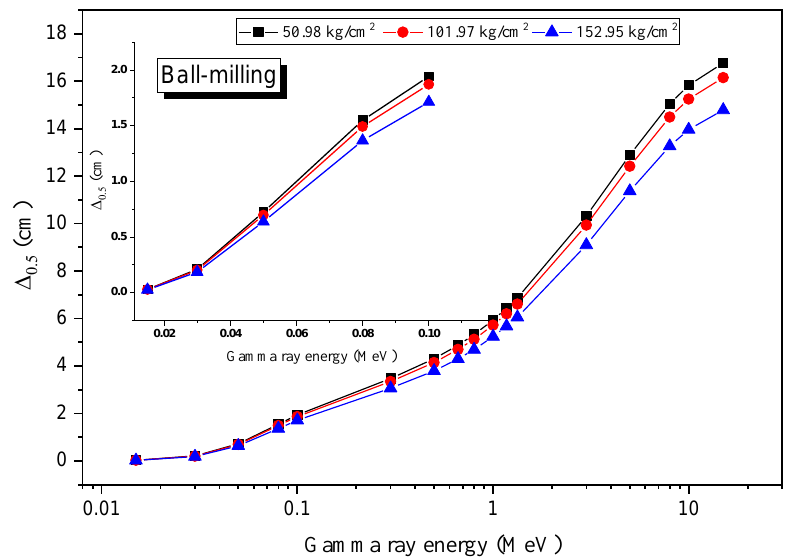
Figure 9. Variation in the half-value thickness versus the energy for the ball-milled bentonite.